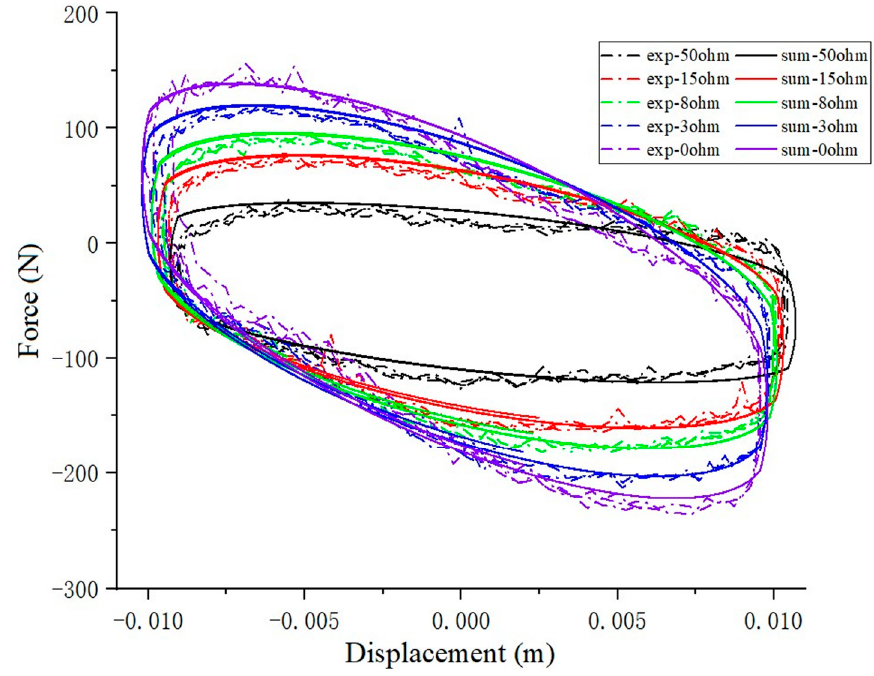
Figure 8. Force-displacement characteristics of VEI device.